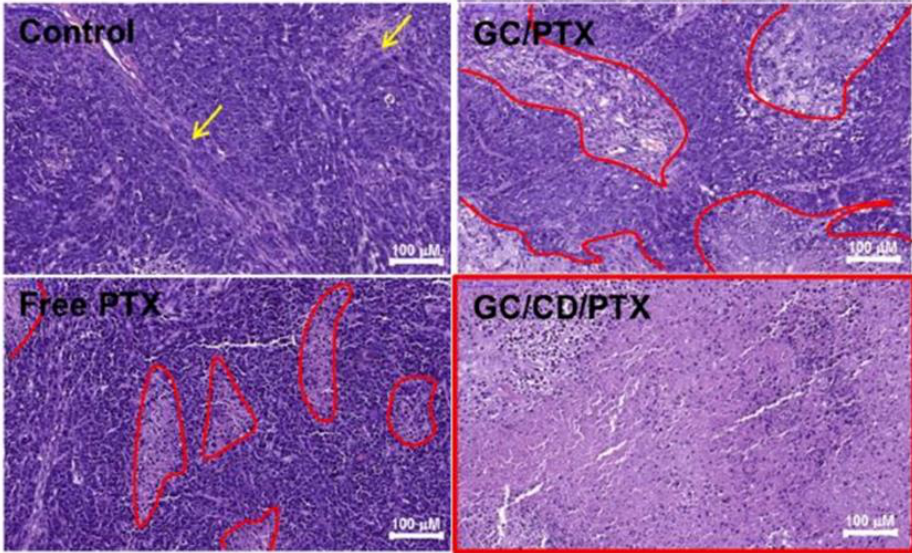
Figure 6. Intratumoral administration of PTX, glycol chitosan (GC)/PTX and GC/CD/PTX in a Scheme 3. bearing mouse model: hematoxylin and eosin-stained images of tumor masses after 7 days. In the control sample, the yellow arrows indicate necrotic tissues induced by the limited expansion of the tumor tissue in the small animal. In the free PTX-, GC/PTX- and GC/CD/PTX-treated samples, the red lines indicate necrotic tissues induced by apoptosis. Adapted with permission from [150], MDPI (2019).